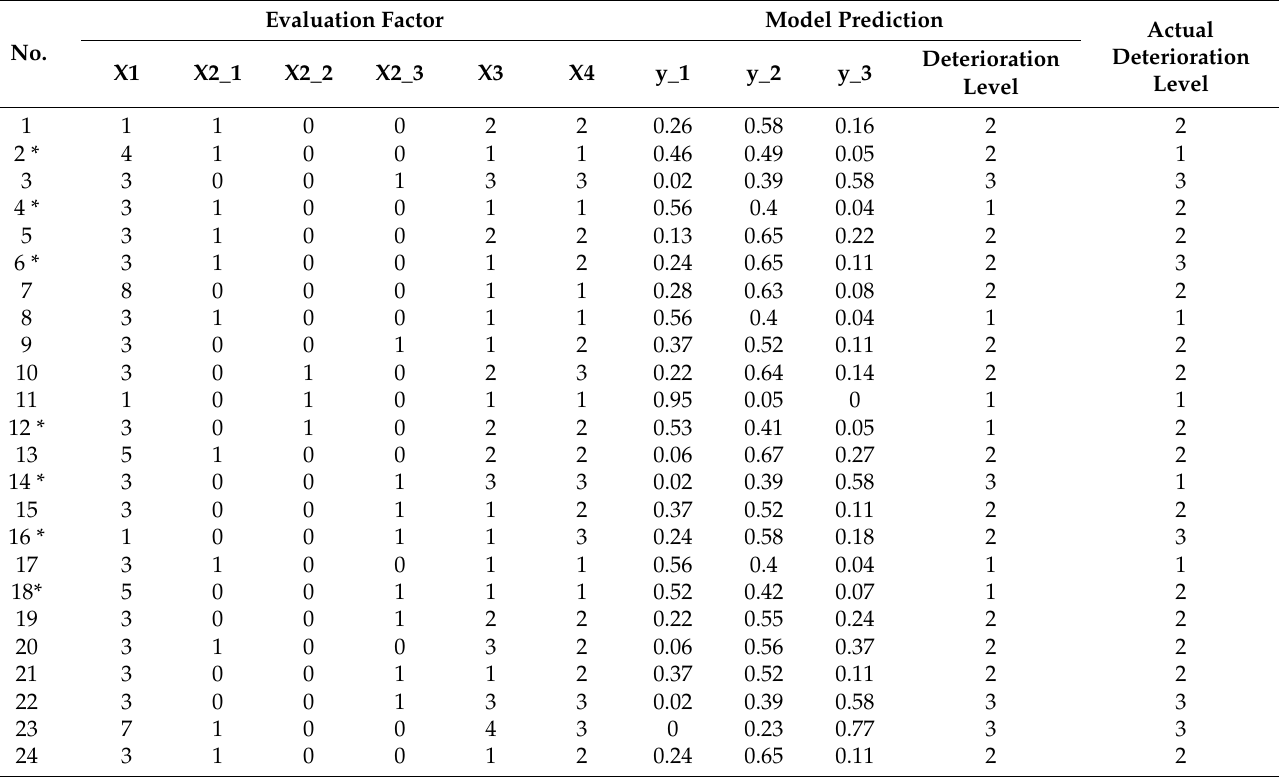
Figure 3. Screenshot of the code of logistic regression algorithm. Table 3. Logistic regression analysis of multi-categorical dependent variables of deterioration level.